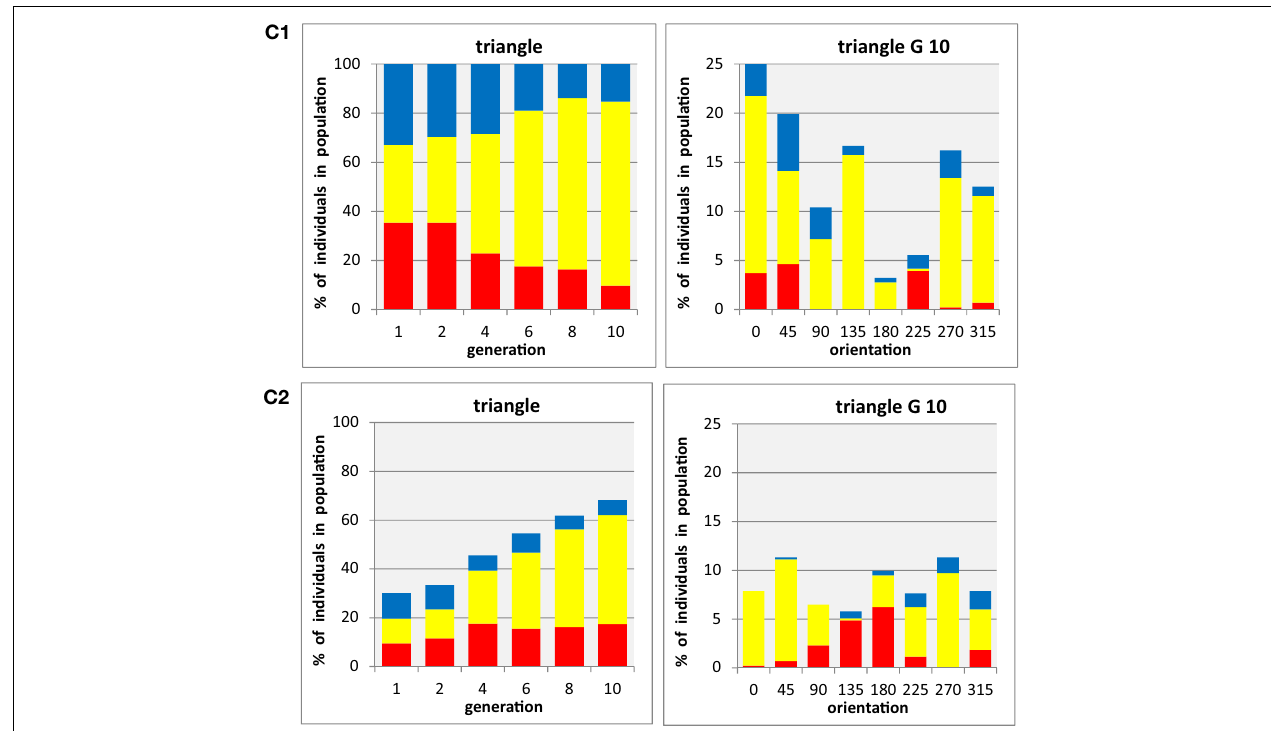
FIGURE 5 | Evolution of populations with three shapes × three colors × eight orientations. (C1) shapes are tested in separate populations containing a single shape each, data shown for triangle (i.e., participants are asked to select the preferred triangle from 24 color-orientation combinations). (C2) all three shapes are tested in mixed population containing all shapes (i.e., participants select the preferred color-shape combination of a given shape presented at any one of eight orientations in the presence of both other shapes, combined with the